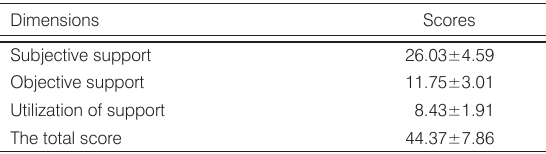
Table 4. Dimensions of social support dimensions of obstetric nurses (mean±SD).